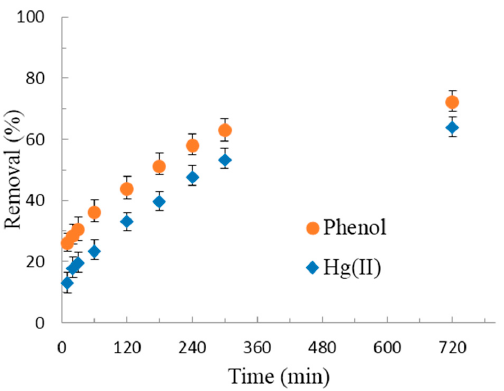
Figure 5. Percentage removal of Hg(II) and phenol using functionalized-AC at various intervals of time (Initial (Hg(II)/phenol) concentrations: ~10 mg/L, pH: 5.0, solid dose: 2.0 g/L, contact time: 12 h).